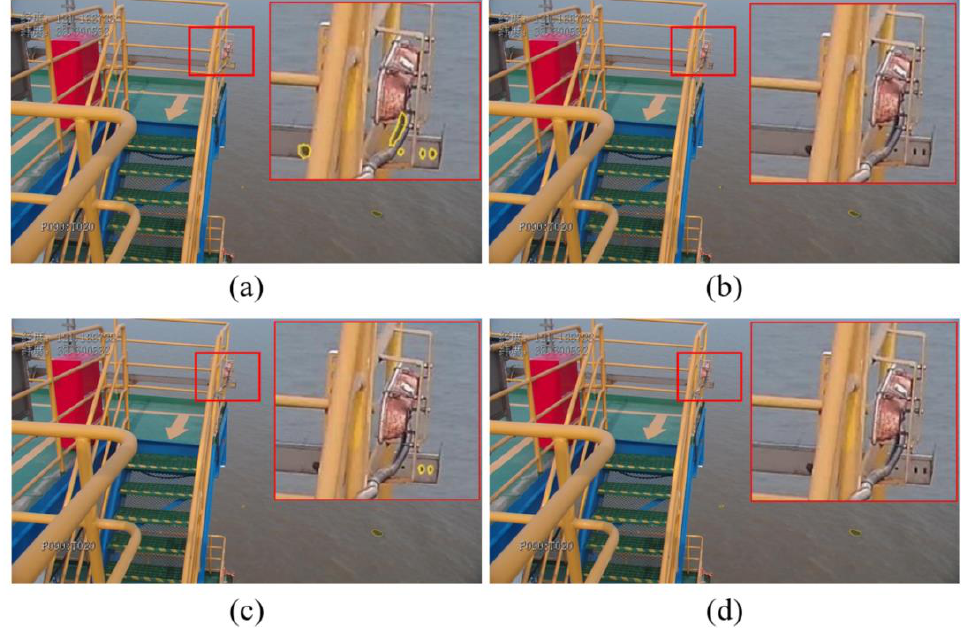
Figure 20. The comparison of ResNet and Coordinate ResNet in AlgaeFiner. ( a ) is the AlgaeFiner with R50, ( b ) is the AlgaeFiner with C-R50, ( c ) is the AlgaeFiner with R101, ( d ) is the AlgaeFiner